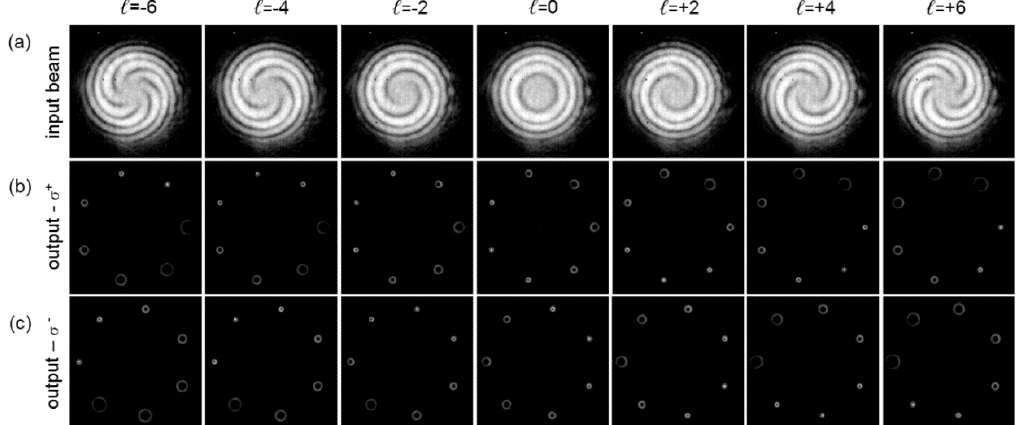
Figure 9. Optical characterization of the demultiplexer in Figure 4. ( a ) Experimental interference pattern of the input beams. The twist-handedness and number of the spiral arms reveal the sign and value of orbital angular momentum, respectively. Experimental output intensity for input right-handed ( b ) and left-handed ( c ) circular polarization states. The position of the far-field bright spots is in accordance with the channel scheme depicted in Figure 4b. 4. Discussion In this work, we described the design, nanofabrication, and optical characterization of silicon metasurfaces for the parallel sorting of orbital angular momentum and polarization using the method of optical-mode projection. The samples were fabricated in the form of dielectric Pancharatnam–Berry optics, whose inhomogeneous anisotropy imparts a spatially-variant phase-change due to a local control of the input polarization. In particular, the phase is geometric in nature and equal to twice the rotation angle of the local extraordinary axis, corresponding to the direction of the subwavelength grating vector. Three different sorters have been designed and fabricated, performing combined PDM and OAM-MDM over different OAM sets and channel configurations, with the aim to exhibit the versatility of the demultiplexing method in terms of channels geometry and OAM values. In particular, we demonstrated the possibility to sort a symmetric range of OAM beams over a linear array and over 2D regular distributions, specifically a regular polygon and a semicircle. By properly designing the far-field channel scheme, fixed by the